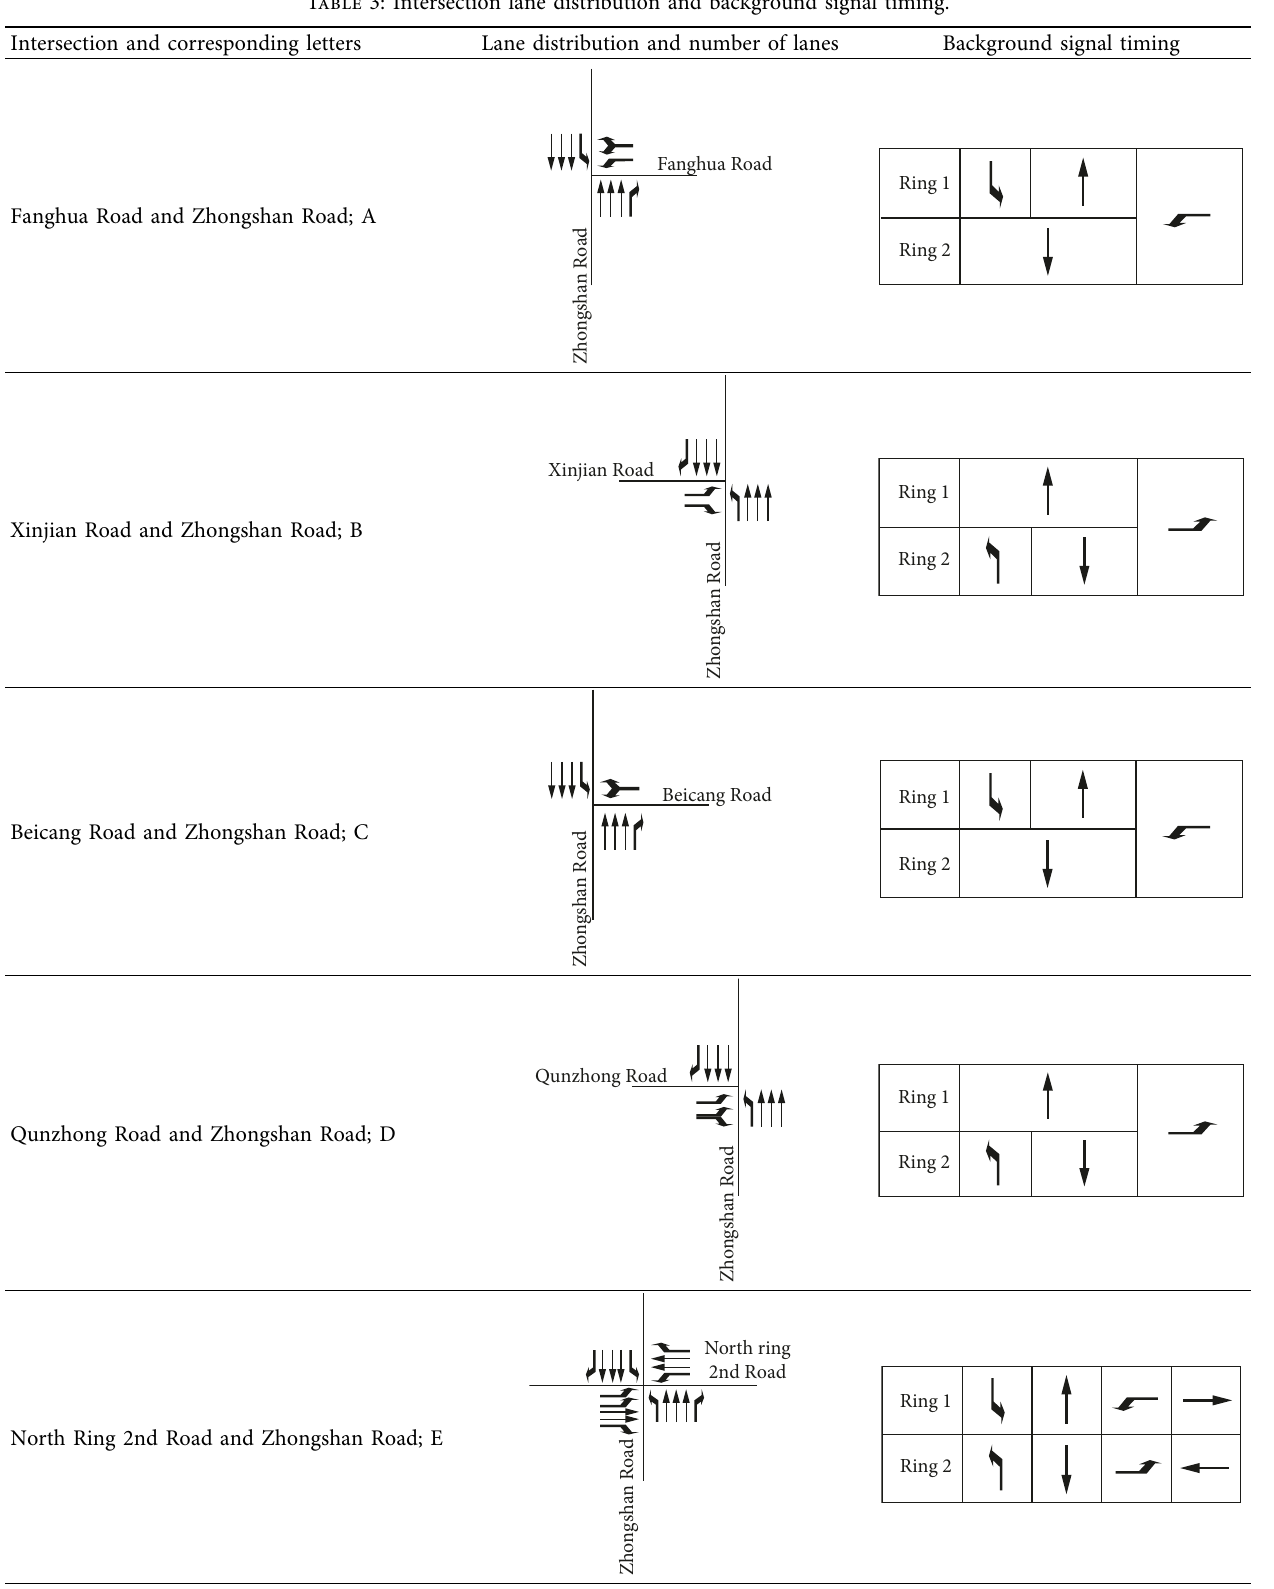
Table 3: Intersection lane distribution and background signal